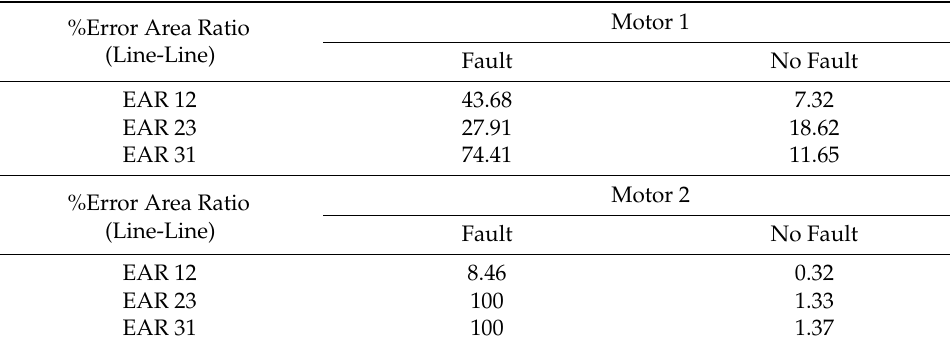
Table 5. Error area ratio index results from tested